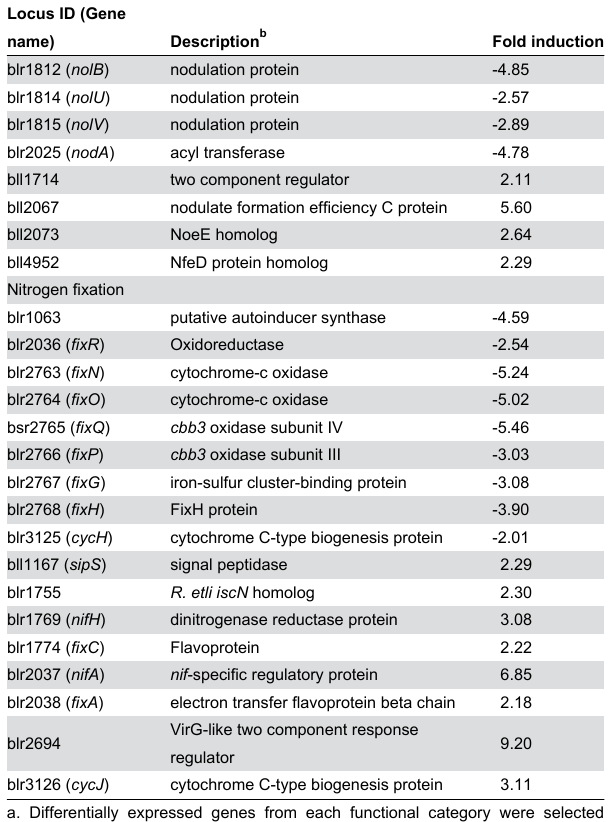
(Table 1). For example, blr1769 ( nifH ), which encodes a dinitrogenase reductase protein, and blr2037 ( nifA ), which encodes a nif -specific regulatory protein, were induced 3.08 and 6.85 fold, respectively. Members of the fixNOQP operon